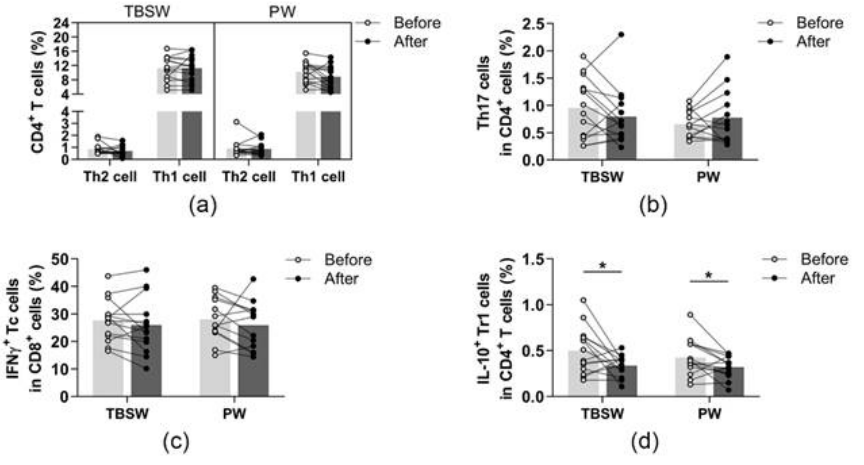
Figure 4. Determination of T helper and T cytotoxic cells with intracellular cytokine analysis in young women before and after the exercise program. The whole blood of 32 healthy participants was stimulated for 5h and stained with monoclonal antibodies with the intracellular staining method described previously. According to the exercise courses, the trainees were divided into total-body- shaping workout (TBSW, n = 14) and Pilates workout (PW, n = 14) subgroups. ( a ) Frequencies of IFN- γ + Th1 and IL-4 + Th2 cells. ( b ) Percentages of IL-17 + Th17 cells. ( c ) The ratio of IFN- γ -producing Tc cells. ( d ) Proportions of IL-10-producing type-1 regulatory (Tr1) cells. A paired T-test was used. Each data point represents an individual subject, while bars show the mean values. Statistically significant differences are indicated by * p <